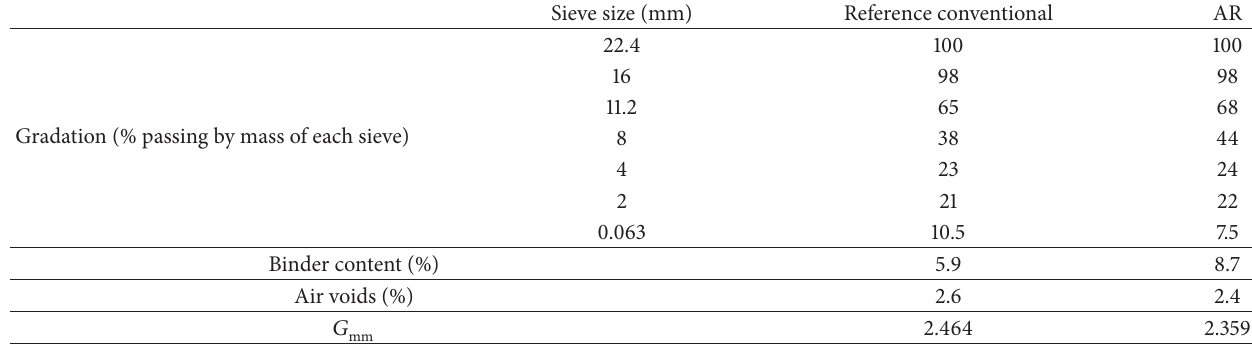
Table 1: Average aggregate gradations and mixture characteristics, Stockholm highway.